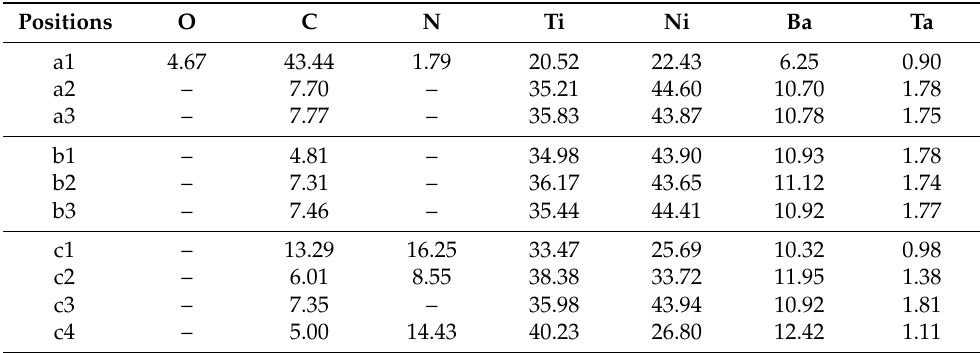
Figure 4. The cross-section SEM images of NiTi alloy after laser nitriding: ( a ) laser nitriding with a scanning speed of 80 mm/s and frequency of 100 kHz at room temperature (sample S-2), ( b ) laser nitriding with a scanning speed of 40 mm/s, and frequency of 200 kHz at low temperature (sample S-4). ( c ) laser nitriding with a scanning speed of 40 mm/s and a frequency of 200 kHz at room temperature (sample S-3). Table 2. The EDX elemental analysis along the cross-section of the NiTi alloy after laser nitriding (marked in Figure 4, At%).